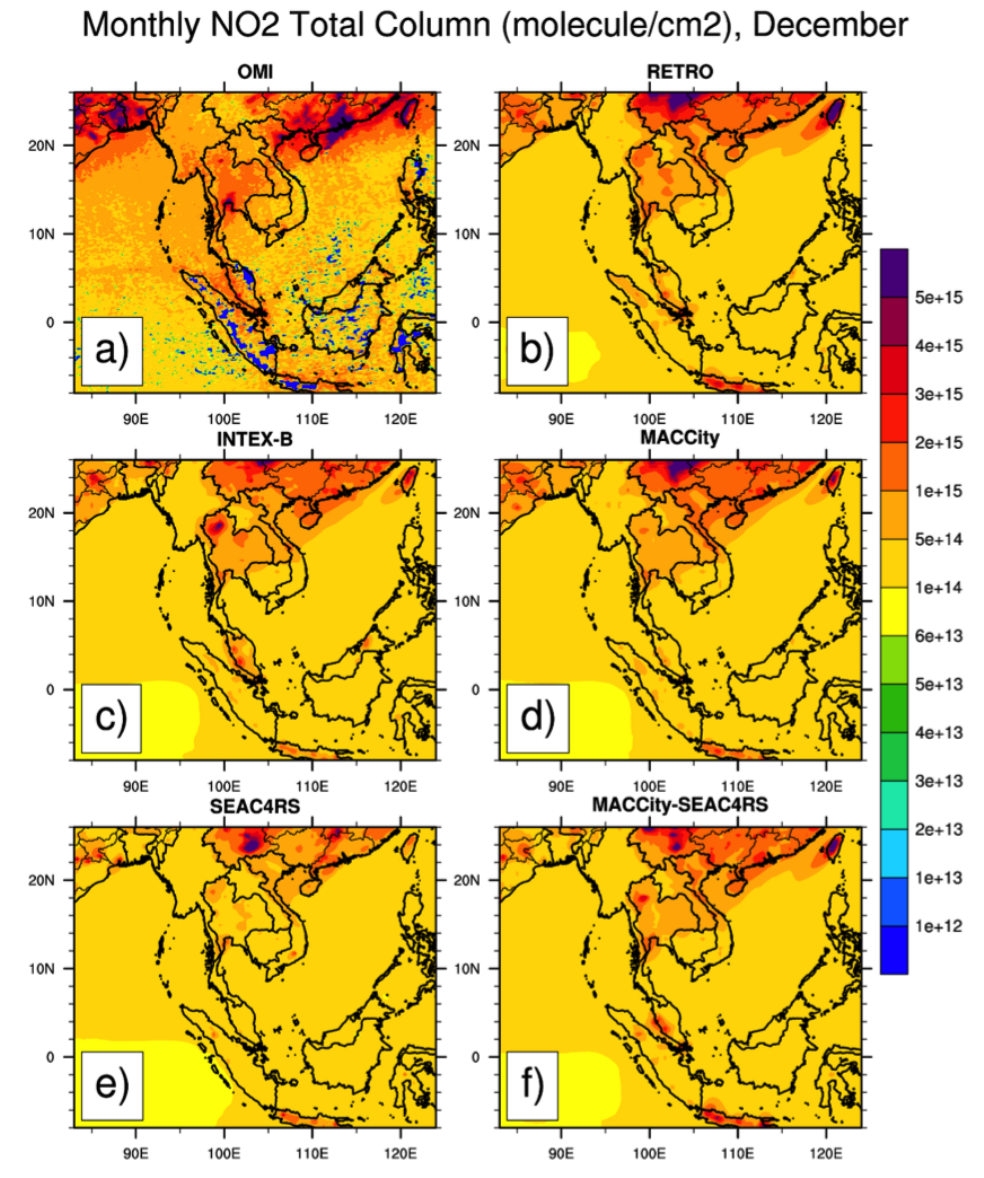
Figure 15. Same as Fig. 19 but for